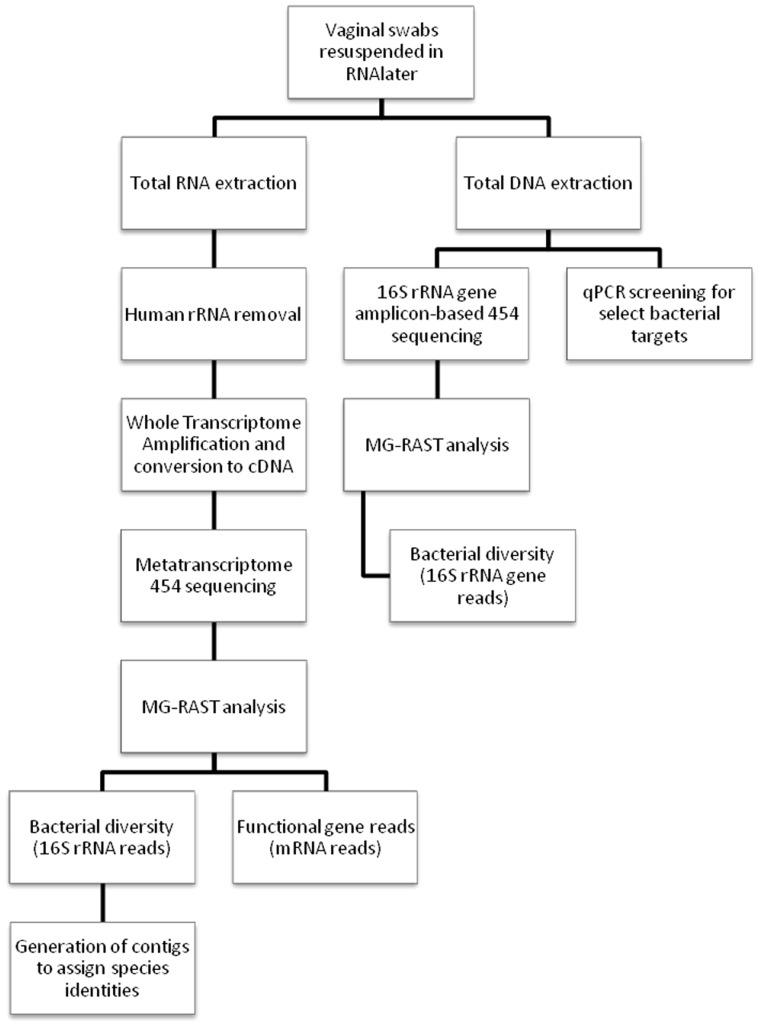
Overview of experiment.Flow chart of the work plan for this study.